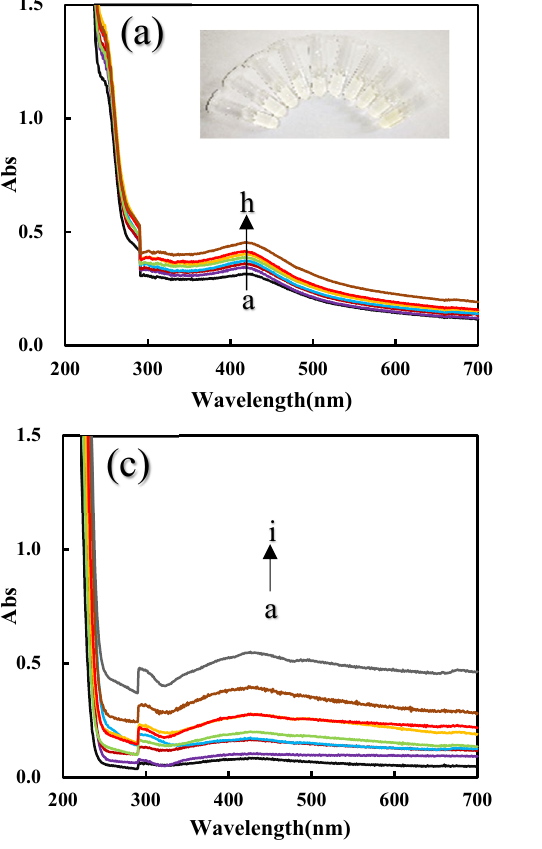
Figure 7. UV absorption spectra of the analysis system. ( a ) a to h: (0, 0.067, 0.13, 0.2, 0.27, 0.33, 0.67,